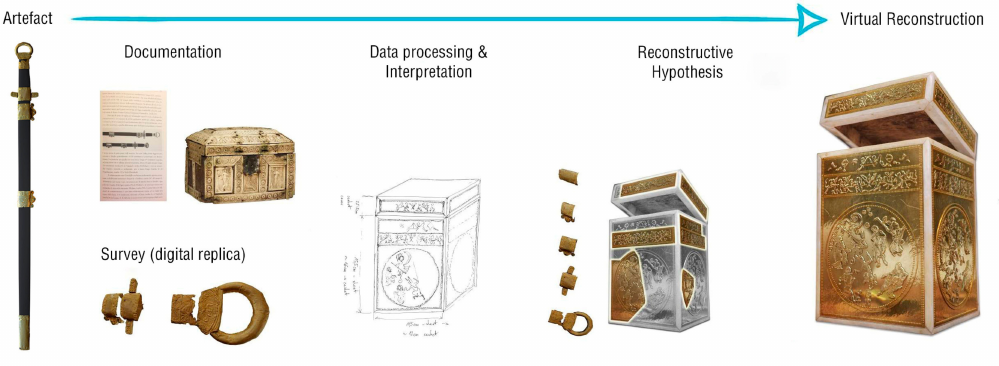
Figure 9. Workflow of the virtual reconstruction the process of a Byzantine casket, starting from the golden sheets applied on the scabbard of the kun à gota